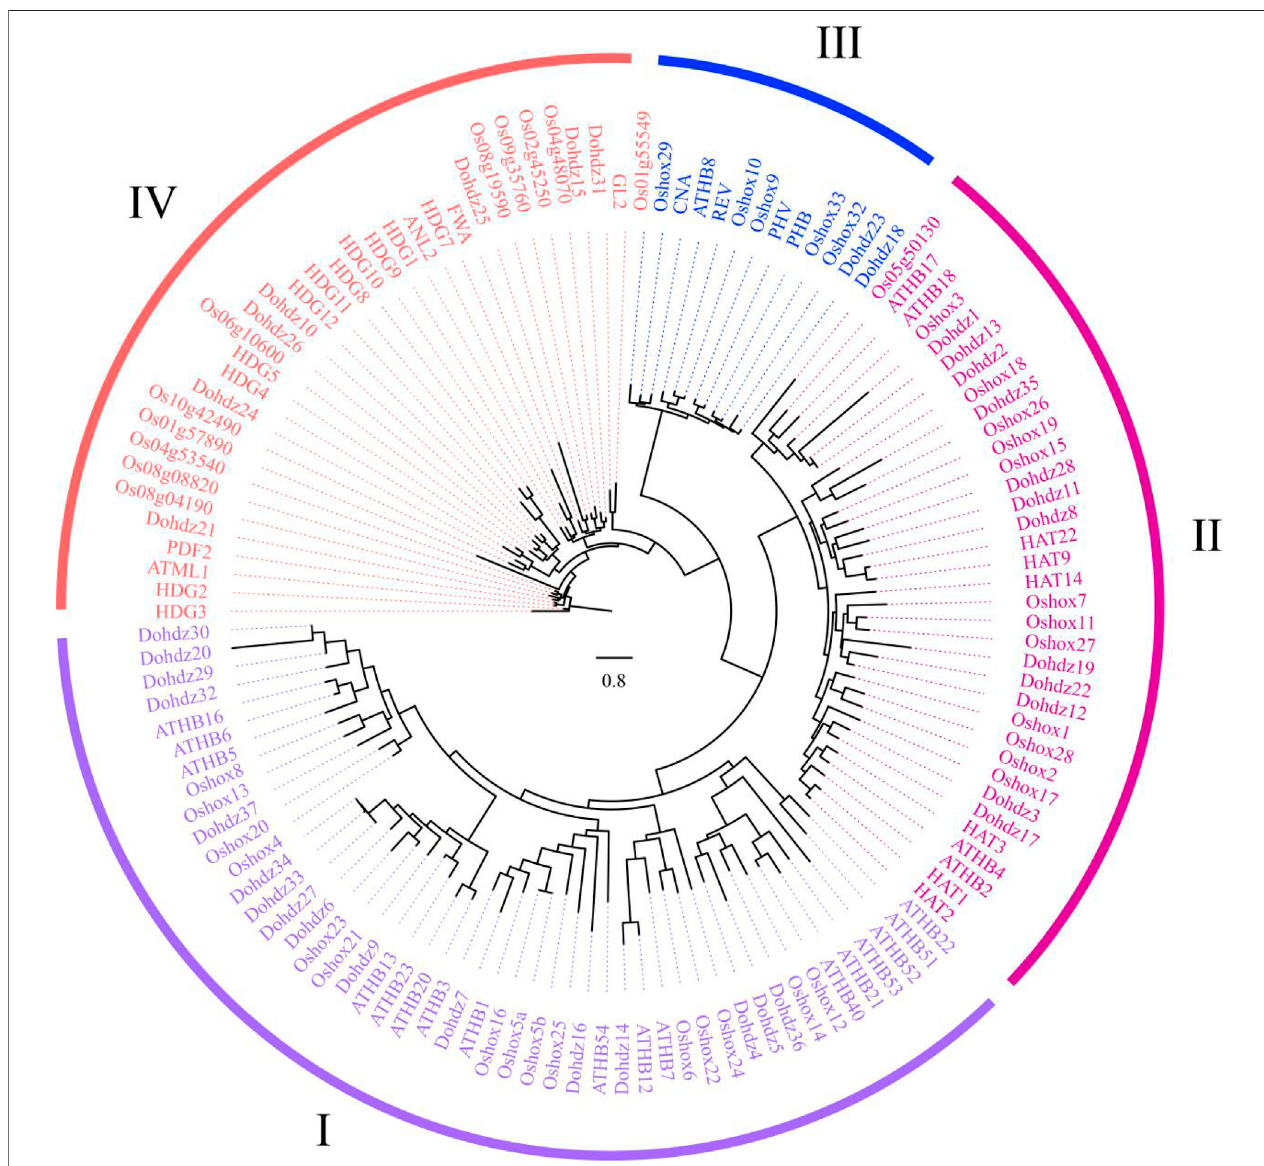
FIGURE 1 | Phylogenetic analysis of HD-ZIP proteins in D, of fi cinale (37), Arabidopsis (48), and rice (39) based on the Maximum Likelihood (ML) method using RAxML software.